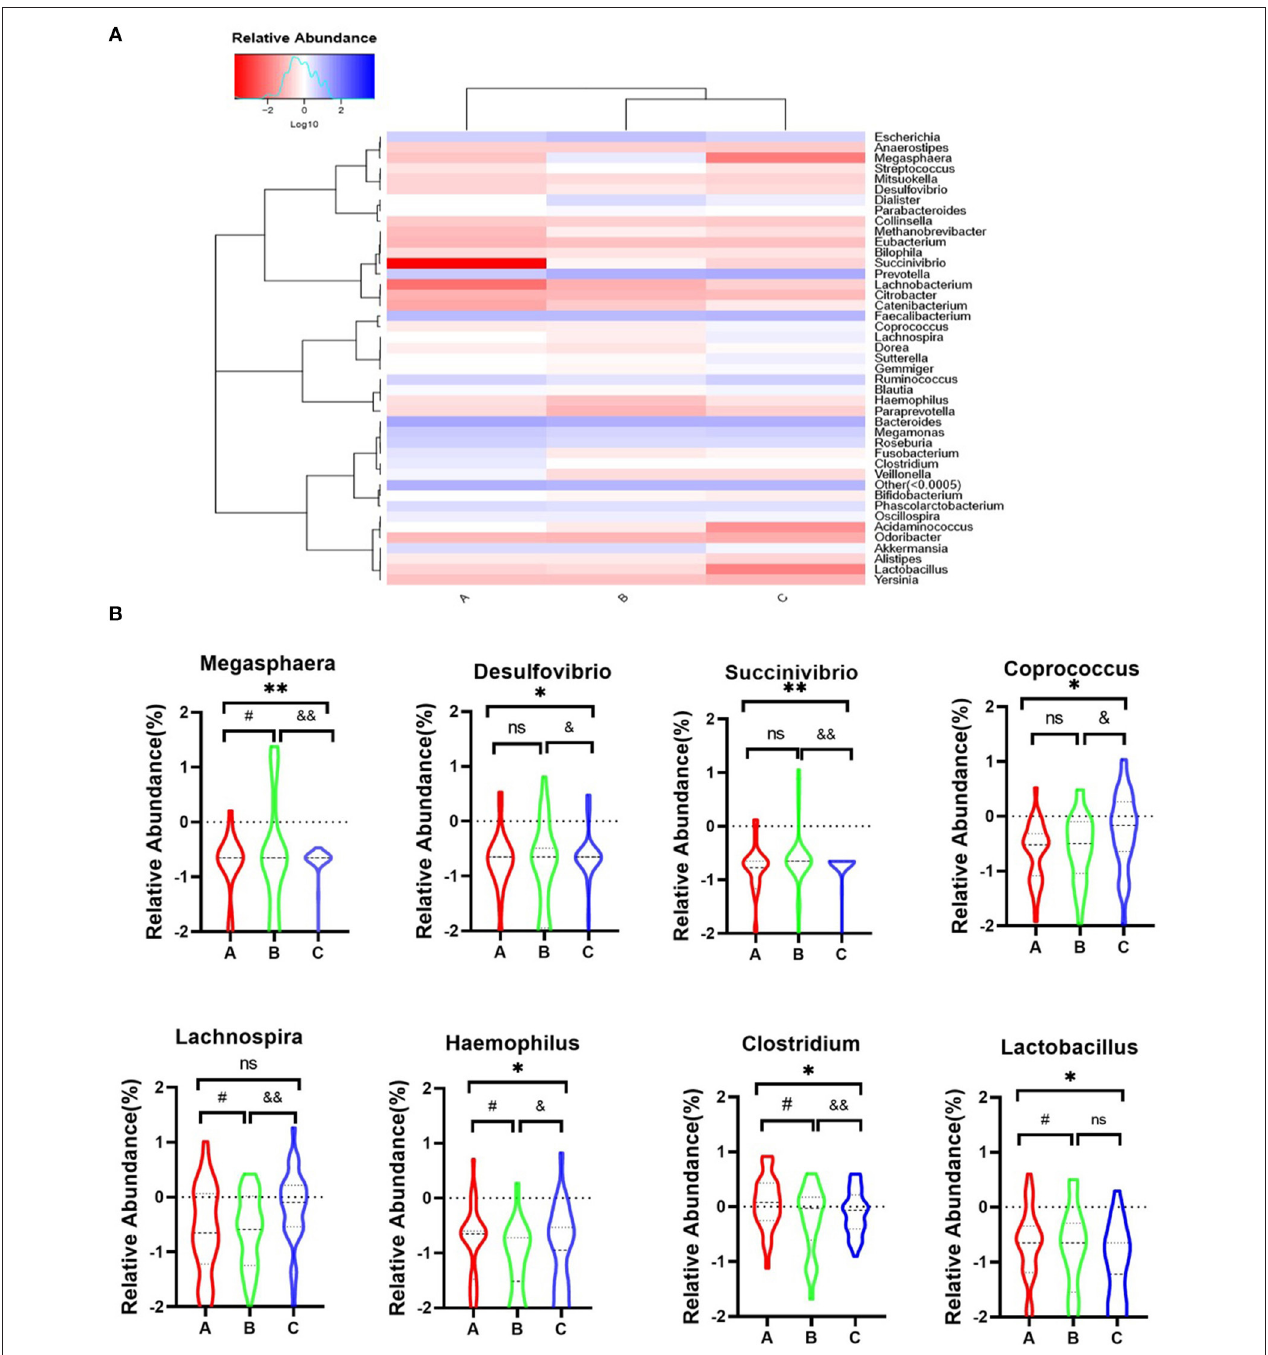
FIGURE 4 | Heatmap representation of genus level of gut microbiota in three groups. (A) Heatmap of the 42 most counts abundant taxa. On top of the heatmap, group of samples are colour-coded. (B) A, Acute set stage group; B, Remission stage group; C, Healthy control group. * P A − C ≤ 0.05, ** P A − C ≤ 0.001, # P A − B ≤ 0.05, & P B − C ≤ 0.05, and && P B − C ≤ 0.001.